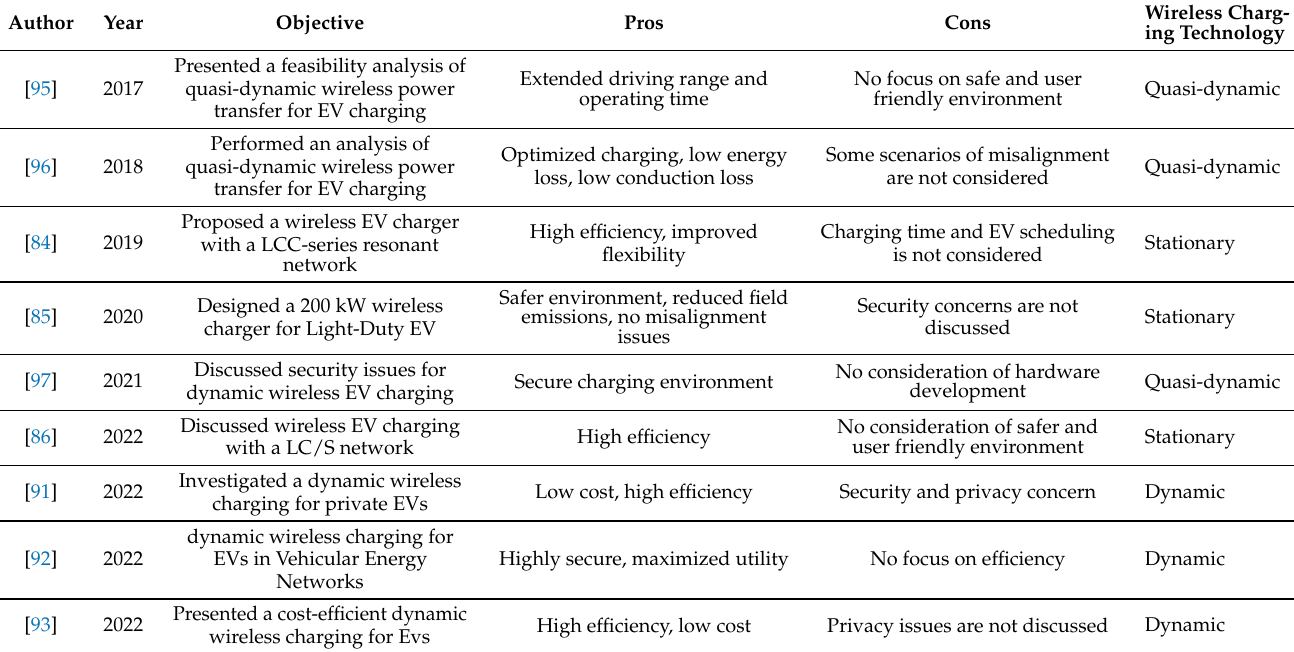
Table 4. Comparative analysis of various wireless charging